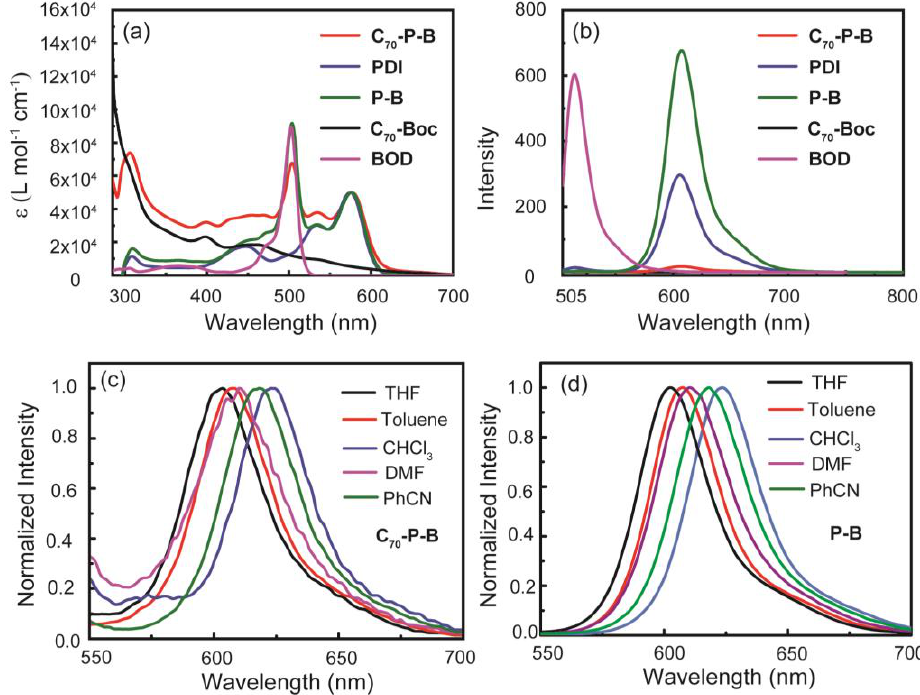
Figure 3. ( a ) UV-vis absorption and ( b ) fluorescence spectra of C 70 -P-B , the reference compounds PDI , P-B , C 70 -Boc and BOD in toluene (c = 1.0 × 10 −5 mol/L for PDI , P-B and C 70 -Boc , c = 1.0 × 10 −6 mol/L for BOD ). Emission of ( c ) C 70 -P-B and ( d ) P-B in THF, CHCl 3 , DMF, PhCN and toluene. Exited at 489